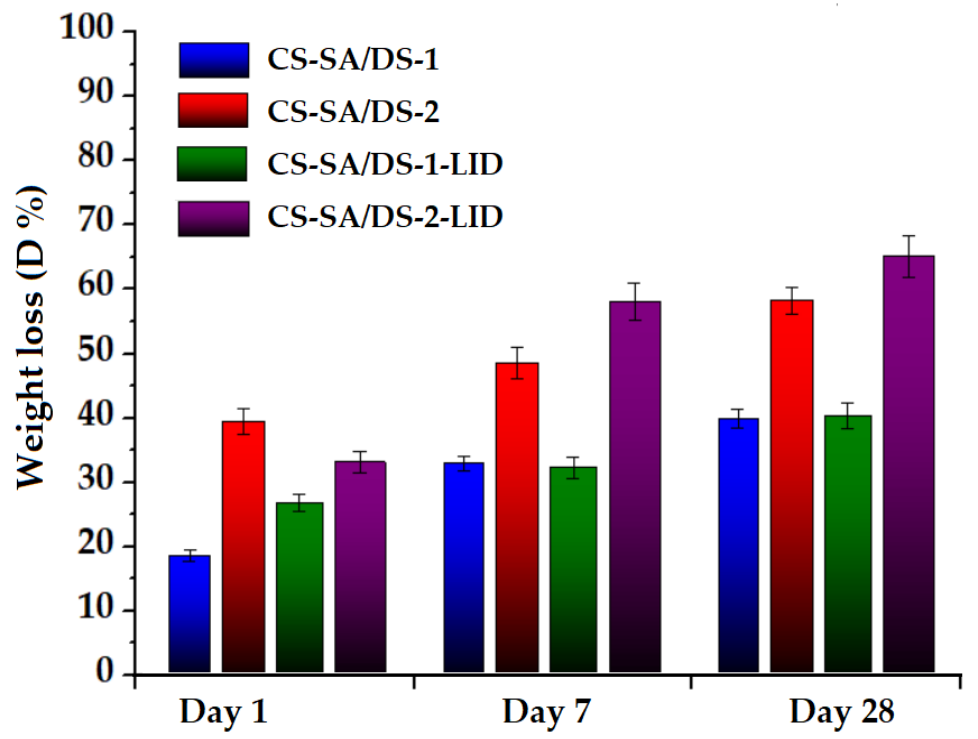
Figure 5. Weight losses of the chemically modified chitosan membrane with and without lidocaine content.